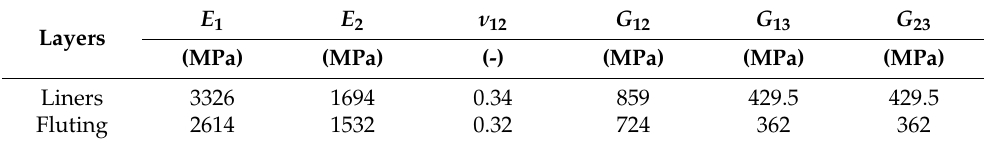
Table 1. Material data for orthotropic constitutive model of corrugated cardboard layers.